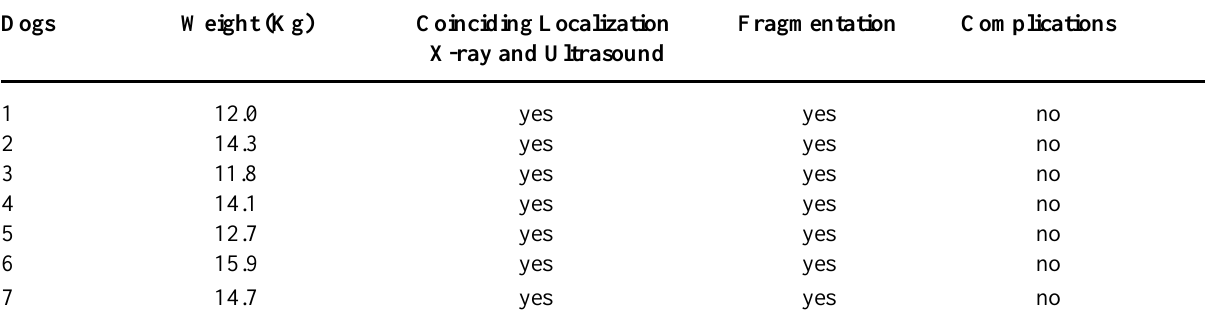
Table 1 – List of animals with localization, fragmentation and complications.